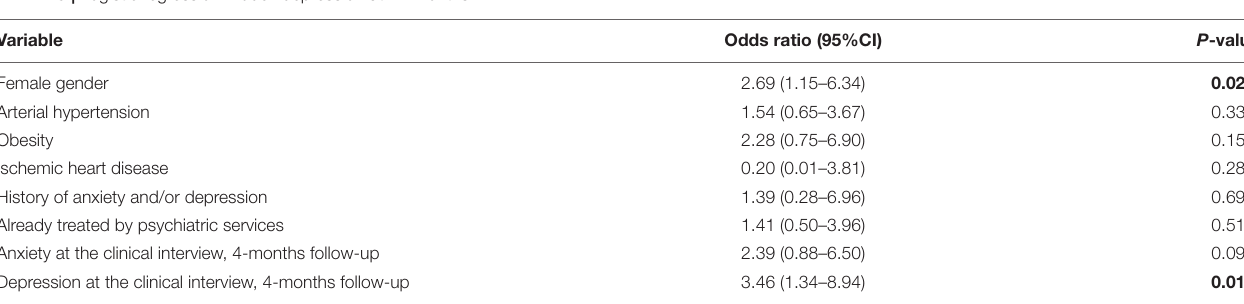
TABLE 5 | Logistic regression model: depression at 12